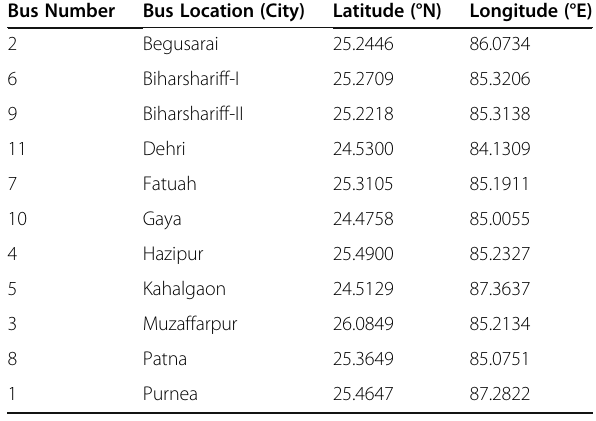
Table 3 Locations of different buses for the Bihar power grid Bus Number Bus Location (City)